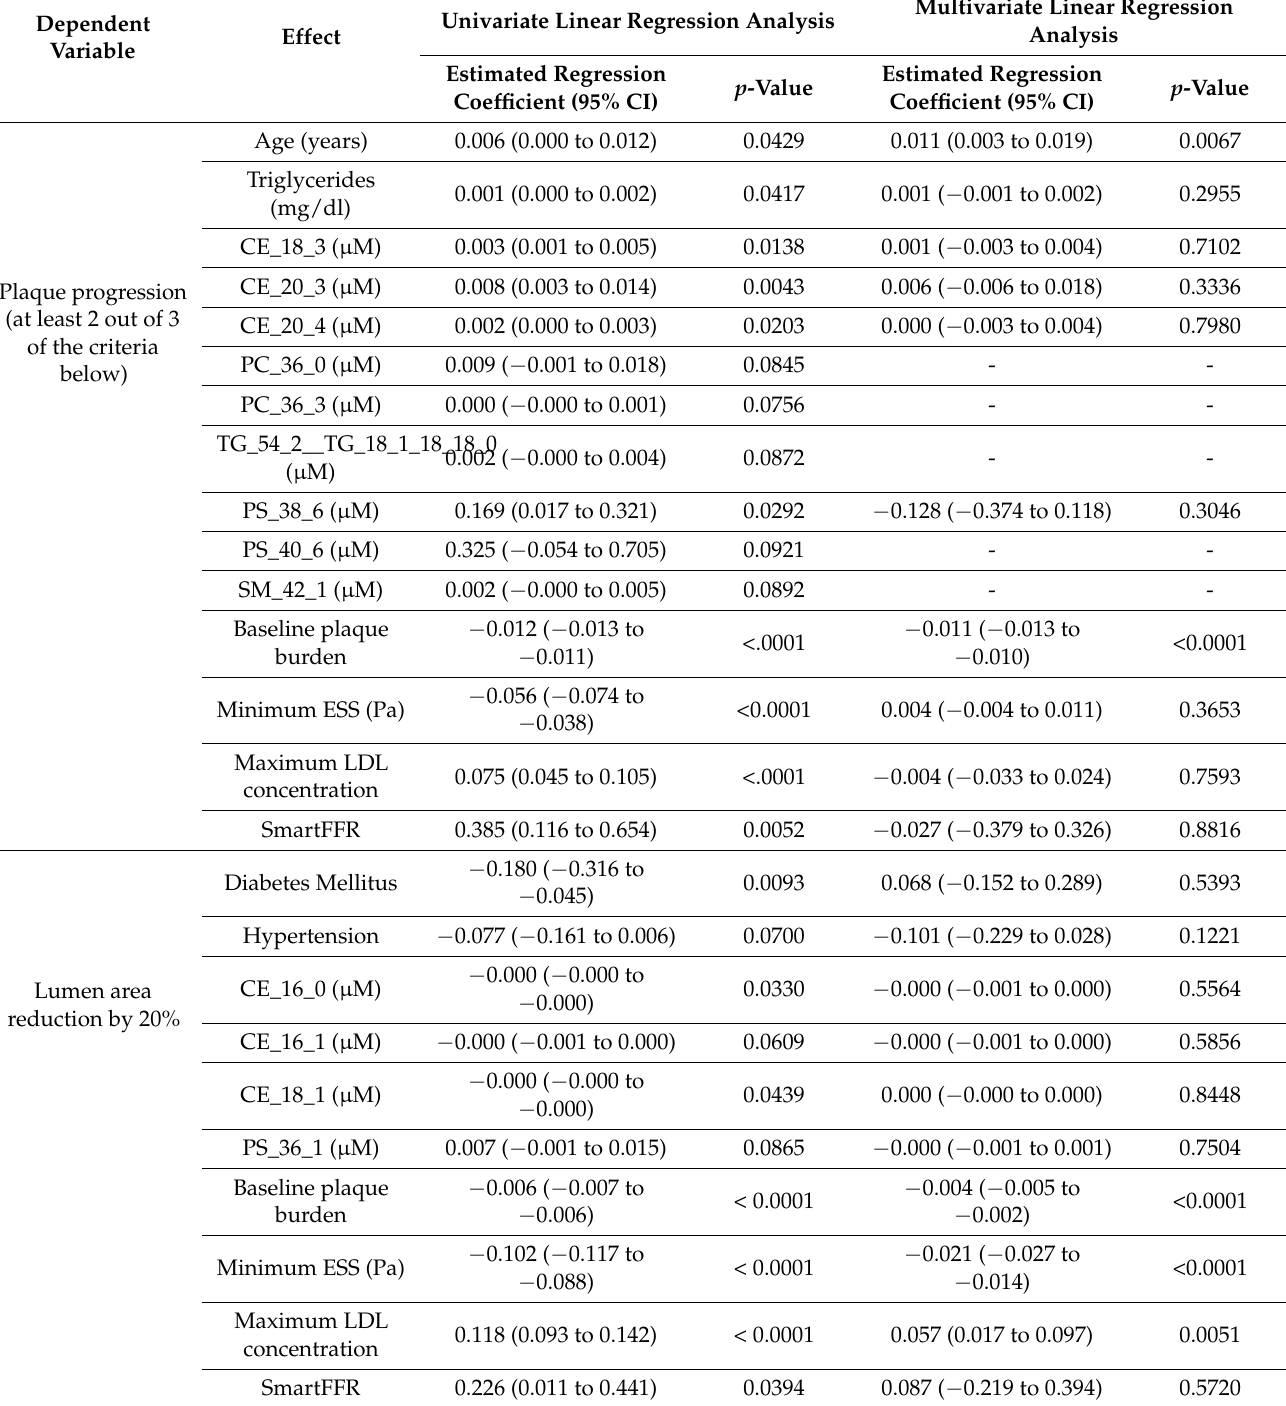
Table 4. Univariate and multivariate linear regression analysis for association of relevant baseline clinical/biohumoral and CCTA variables with single components of plaque progression and their